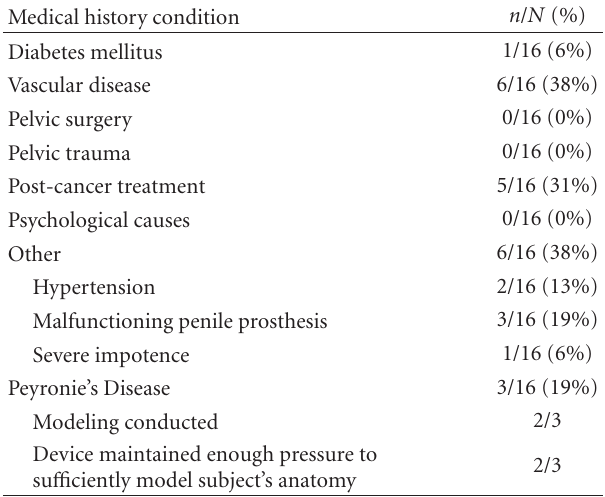
Table 3: Characteristics of implants